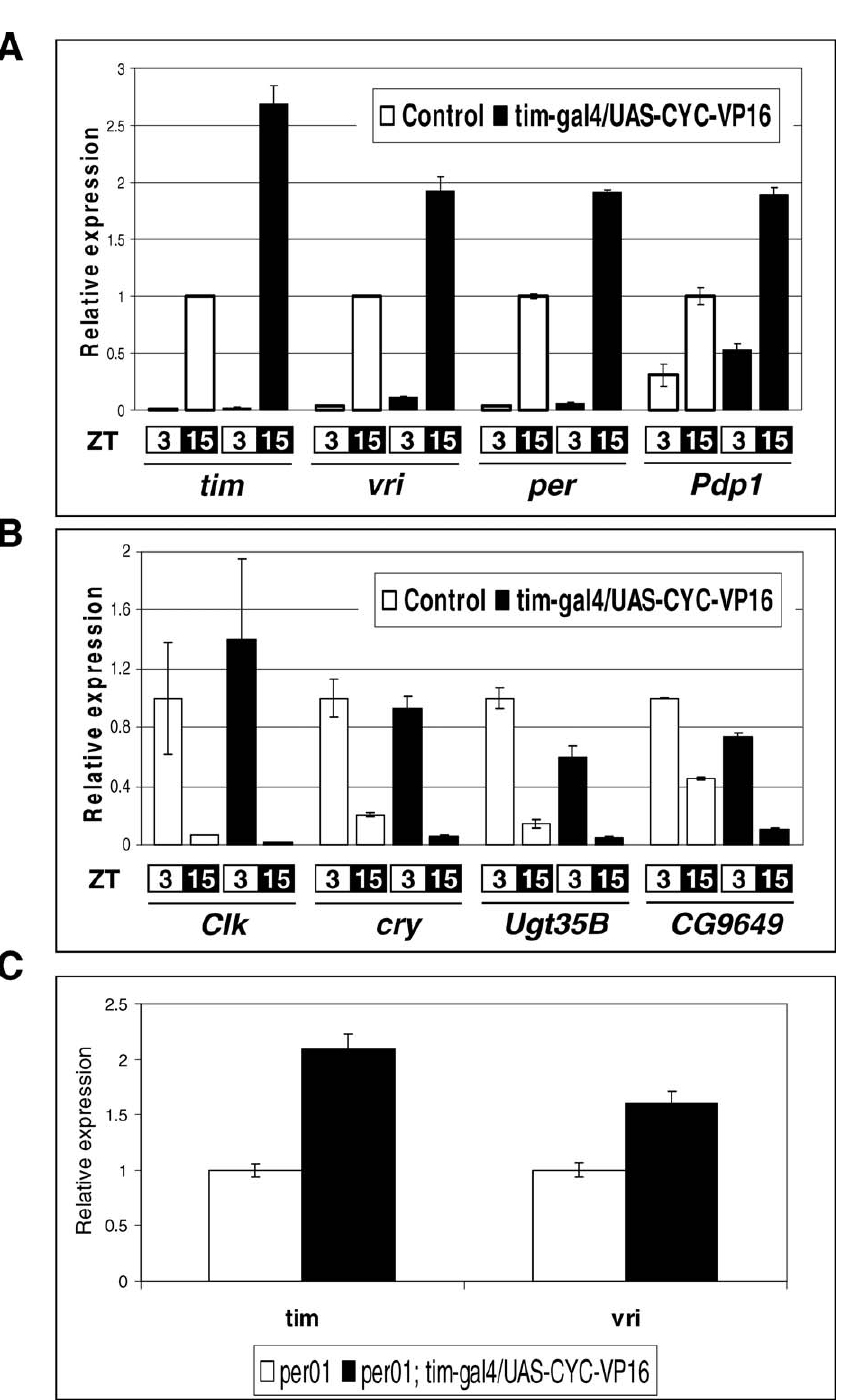
Figure 4. mRNA Levels of Direct CLK Targets Are Selectively Affected in tim - cyc - vp16 Flies (A) mRNA expression value for control ( uas - cyc - vp16 /+, white) and tim - cyc - vp16 flies (black) for two timepoints (ZT3 and ZT15) of four direct Clk targets: tim , vri , per , and pdp1 . The data were obtained by microarray (n = 2 for each genotype and timepoint). The data were normalized to the maximum value obtained in the control flies. Error bars indicate standard error of the mean. (B) mRNA expression value for control ( uas - cyc - vp16 /+, red) and tim - cyc - vp16 flies (blue) for two timepoints (ZT3 and ZT15) of four genes ( Clk , cry , Ugt35B , and CG9649 ) that are not direct CLK targets and that oscillate in control flies with opposite phase than the genes shown in (A). The data were obtained by microarray (n = 2 for each genotype and timepoint). The data were normalized to the maximum value obtained in the control flies. Error bars indicate standard error of the mean. (C) Effect of cyc - vp16 in per 01 mutants flies measured by quantitative PCR. Un-entrained per 01 or per 01 ; tim - gal4 ; uas - cyc - vp16 flies were harvested. RNA was extracted from fly heads, and quantitative PCR was performed. Expression values for each transcript and timepoint were generated by dividing the vri or tim mRNA signal by the expression value for a control non-circadian mRNA ( rp49 ). Expression values are reported as a ratio of tim or vri over rp49 expression. We assigned a value of 1 to the ratio obtained for control flies and proceed as in (A). The data are the average of the normalized vri or tim expression values for three independent RNA samples. The error bars indicate standard error of the